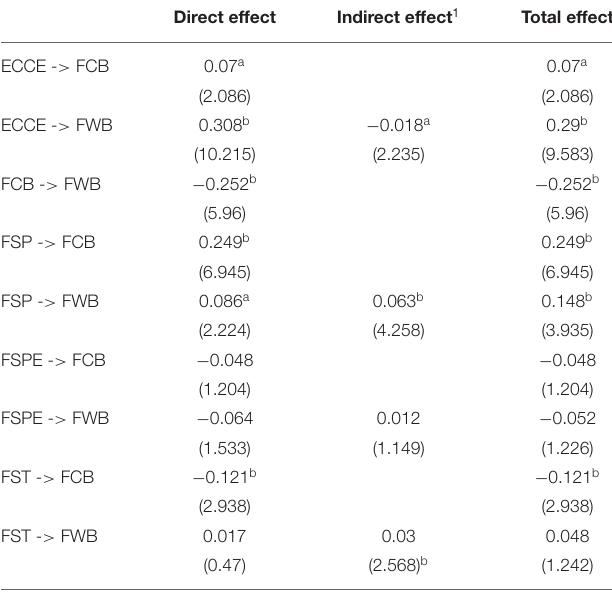
TABLE 5 | Direct, indirect, and total effect of the